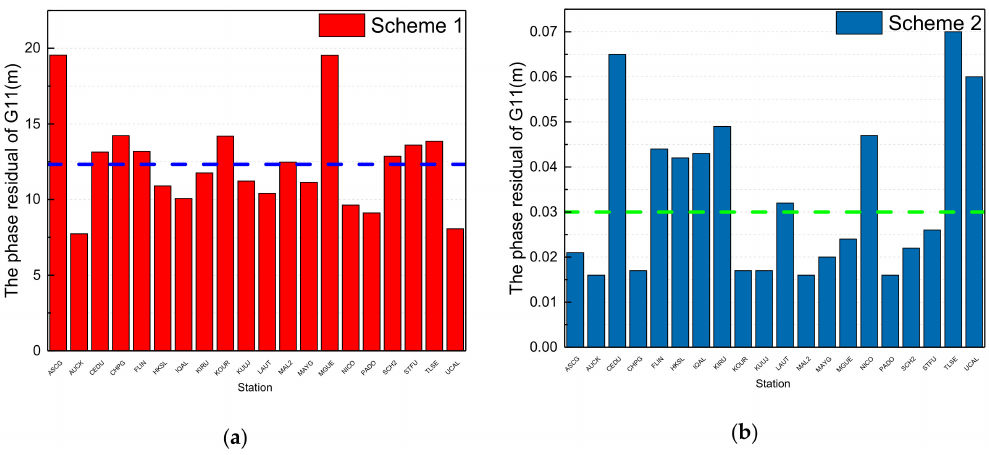
Figure 6. Phase residuals of stations for G11 in the first adjustment for data processing on 1 March 2018: residuals from precise orbit determination according to ( a ) scheme 1 and ( b ) scheme 2.